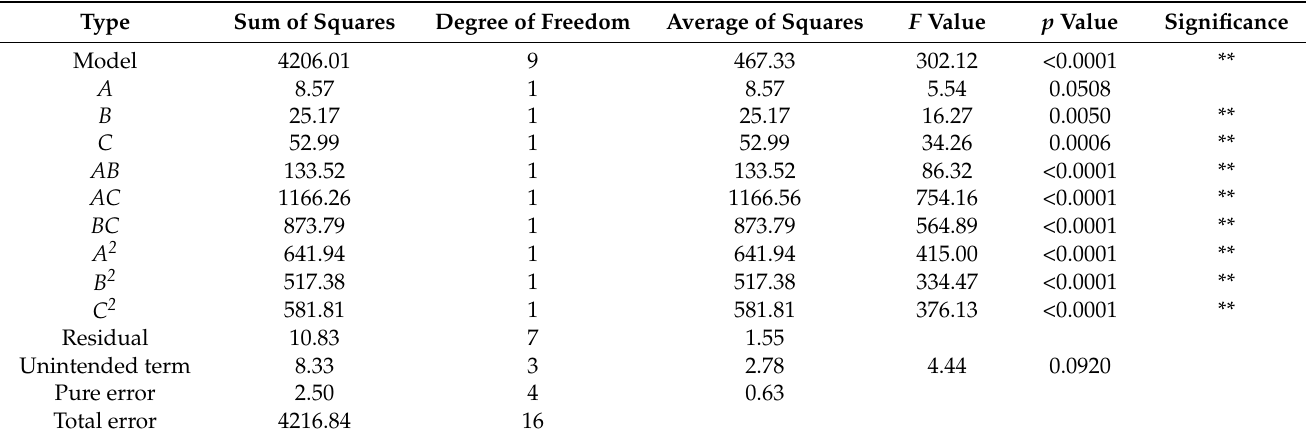
Table 6. Variance analysis of regression